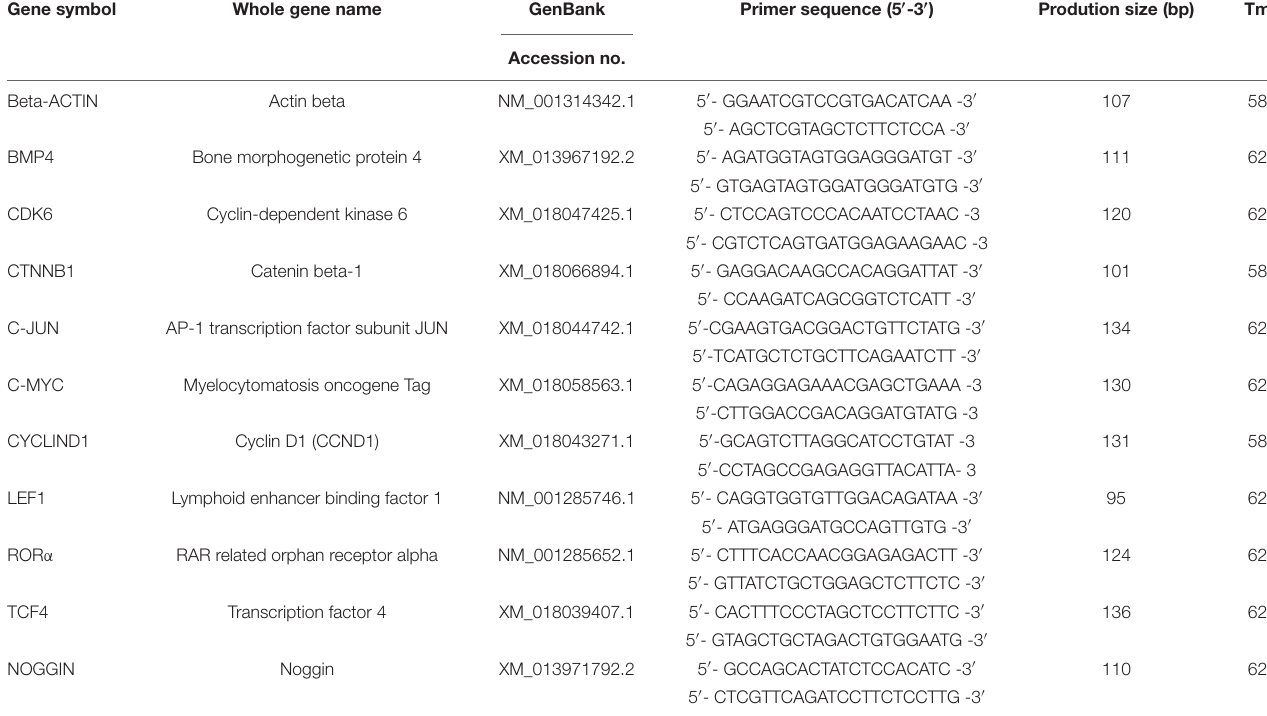
TABLE 1 | Information of primers for real-time quantitative